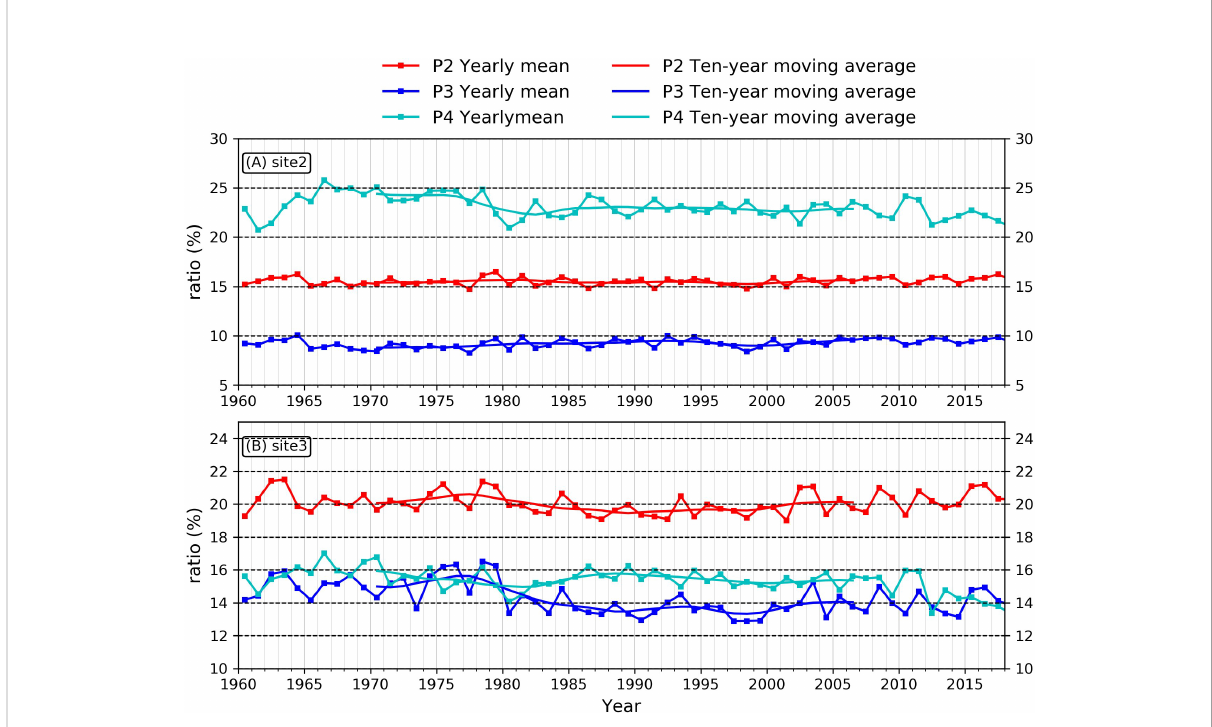
FIGURE 8 Time series of other phytoplankton proportions at (A) site 2 and (B) site 3. P2 denotes nano-phytoplankton, P3 denotes pico-phytoplankton, P4 denotes